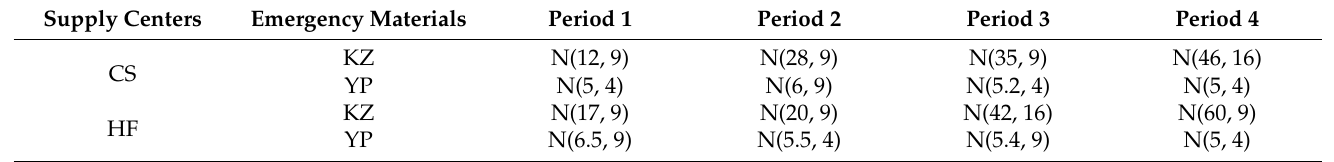
Table 3. Supply of emergency materials at the supply centers at the beginning of each time period.